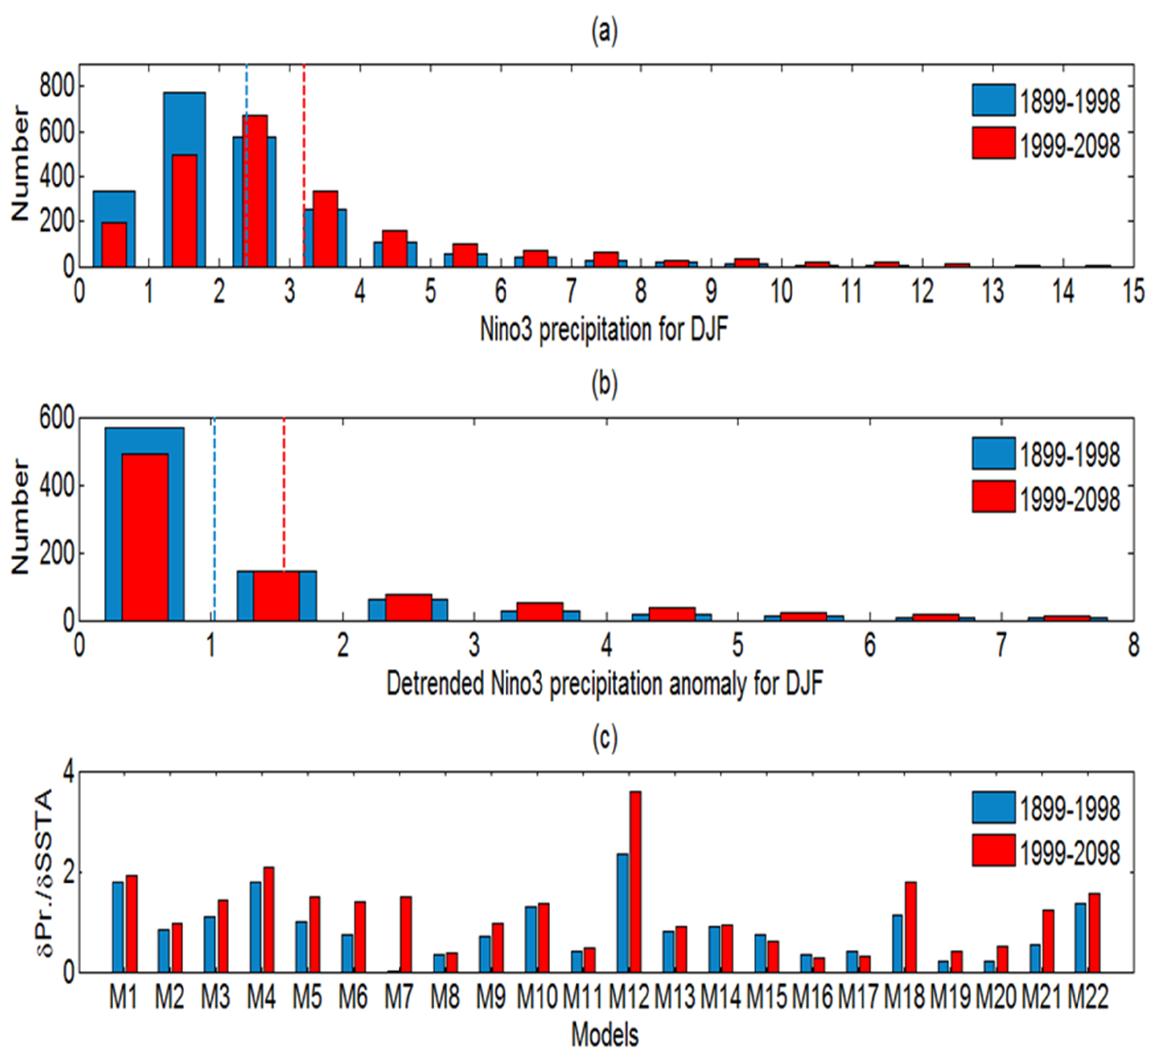
Figure 5. Multi-model histograms of the ( a ) Niño3 DJF precipitation and ( b ) detrended Niño3 DJF precipitation anomalies greater than zero. The samples for the 20th (blue) and 21st (red) centuries are distributed into 1 mm/day bins. The MME mean values during the 21st (red lines) and 20th (blue lines) centuries are shown in ( a ) and ( b ). ( c ) Comparison of regressions of interannual Niño3 DJF precipitation upon local SST anomalies between the 20th and 21st centuries in 22 CMIP5 models.